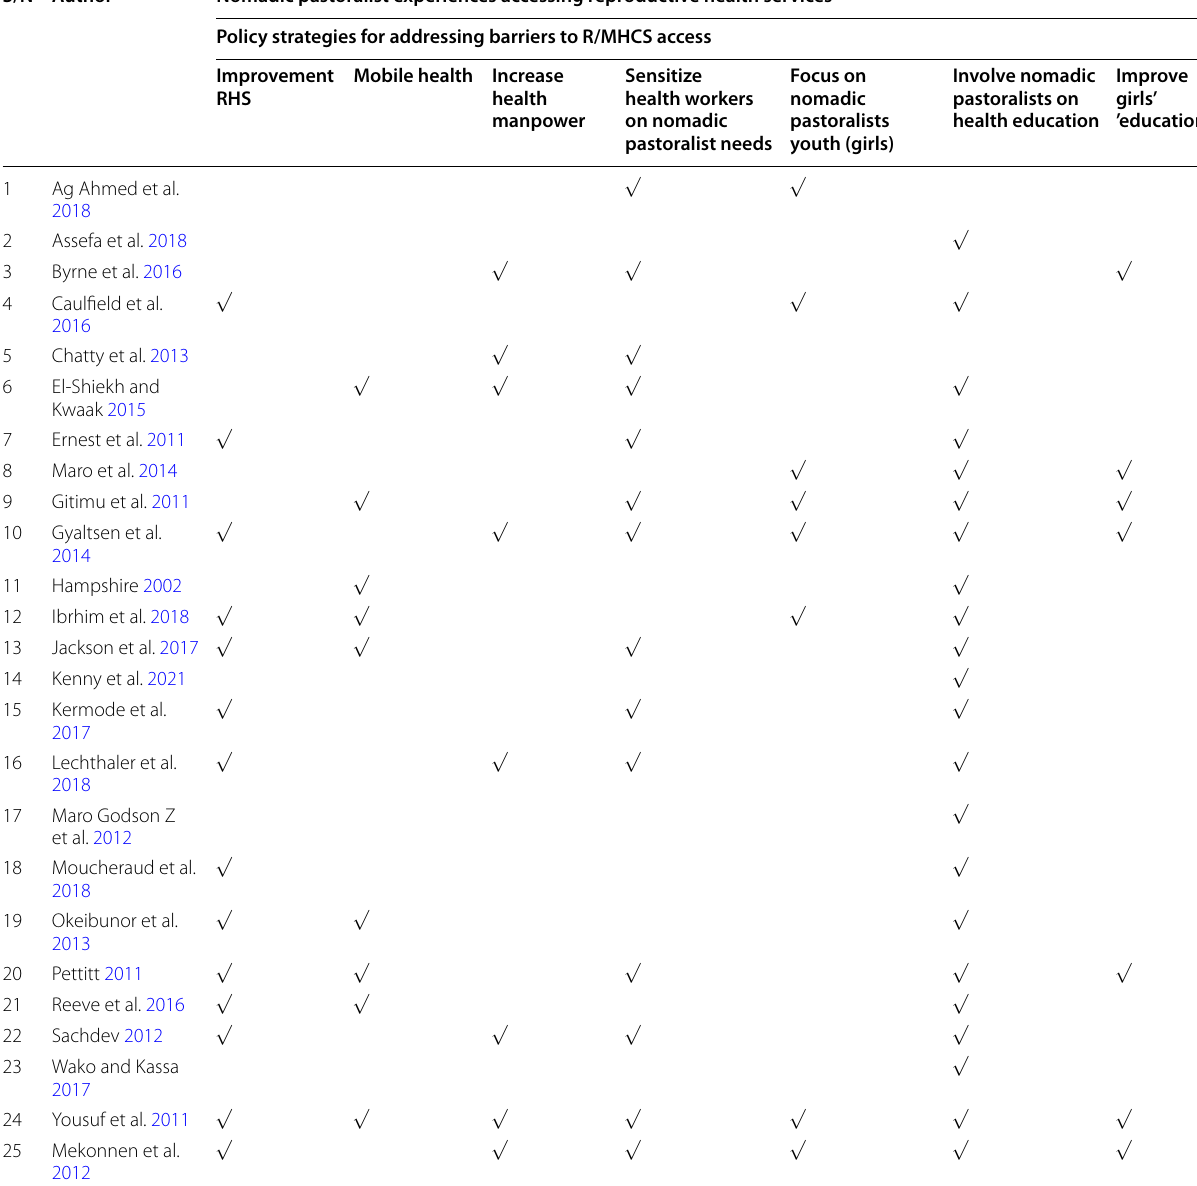
Table 4 Summary of strategies for addressing barriers to R/MHCS